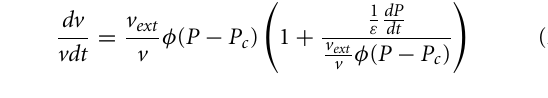
( Figure 6 ) or change in the viscosity of wall material ( Figure 7 )] actually changes both wall extensibility and volume change in cell wall chamber. For example, in Figure 6 , the increase of volume change in cell wall chamber corresponds to the increase in wall extensibility. This leads to a positive R c φ , which implies that cell wall extensibility positively regulates cell wall chamber volume change. This is because Equation (2) indicates that increasing cell extensibility should increase volume change in cell wall chamber. In Figure 7 , the decrease of volume change in cell wall chamber corresponds to the decrease in wall extensibility. This also leads to a positive R c φ , which implies that cell wall extensibility